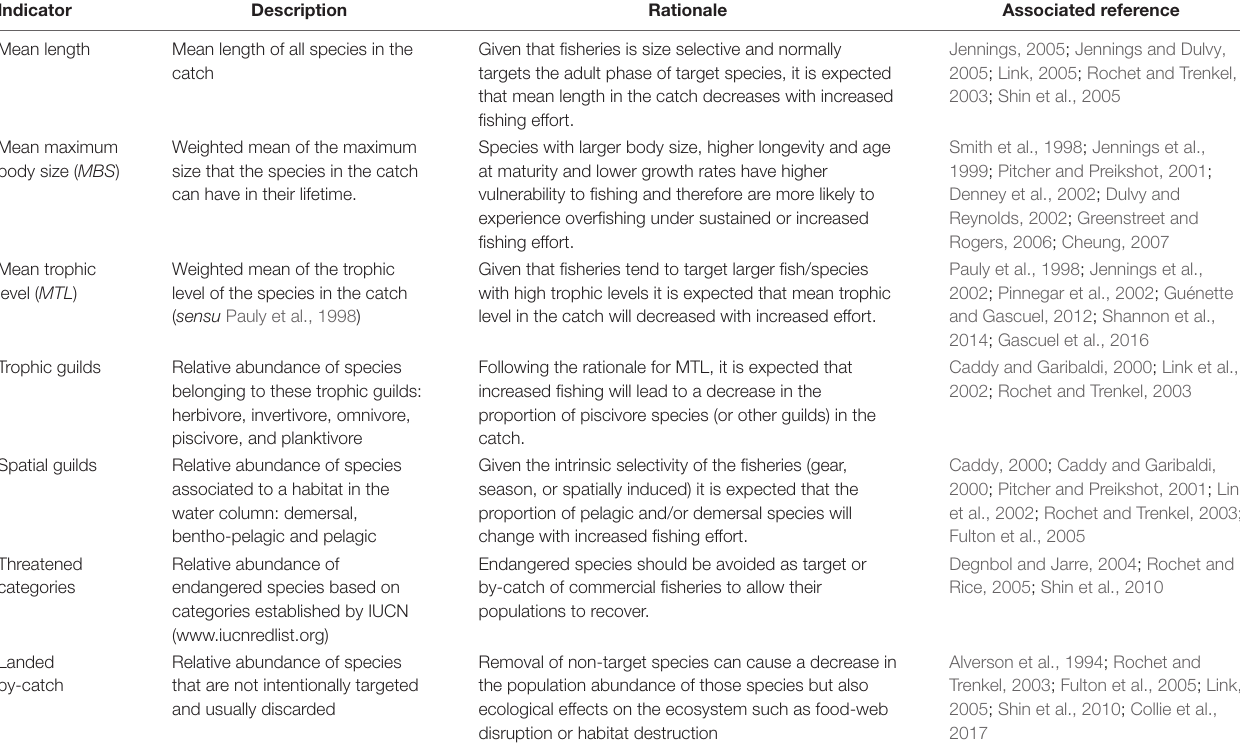
TABLE 2 | Size-based, functional and conservation indicators used here for the assessment of the catch of SSF in the Colombian Pacific.